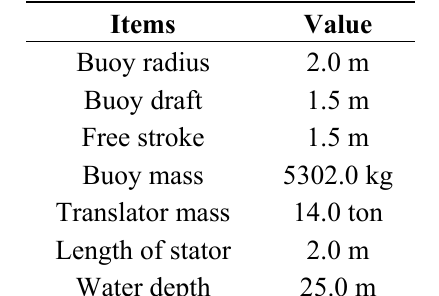
Table 1. Main parameters of the wave energy converter (WEC).